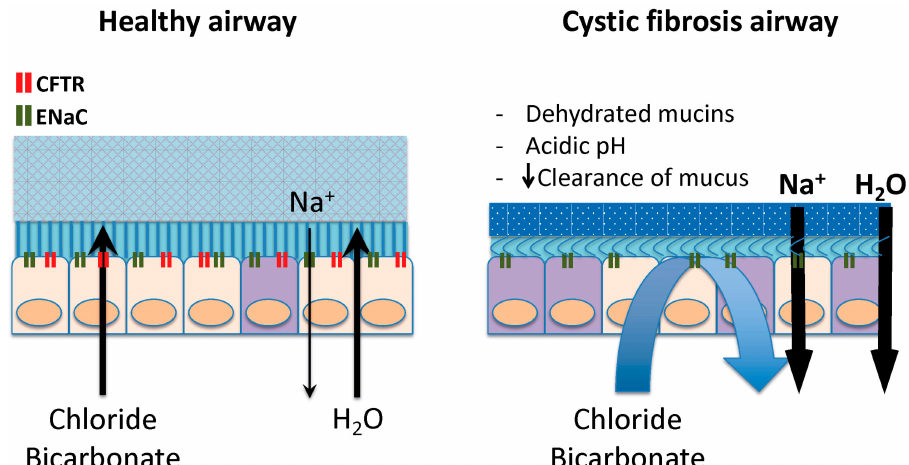
Figure 1. Role of the CFTR in the regulation of mucus viscosity and pH at the epithelial surface. Healthy mucus is composed primarily of mucins and water. Hydration and pH regulate mucus viscosity, and both of these functions are controlled by CFTR at the apical surface of epithelial cells. The movement of chloride dictates the degree to which mucus retains water whereas CFTR-mediated bicarbonate flux plays a key role in defining pH which is critical to healthy anti-bacterial response. In the absence of CFTR, secretions are viscous, adhere to mucosal surface and obstruct cylindrical structures such as small airways and sub-mucosal glands. The acidic pH further contributes to decrease host anti-bacterial